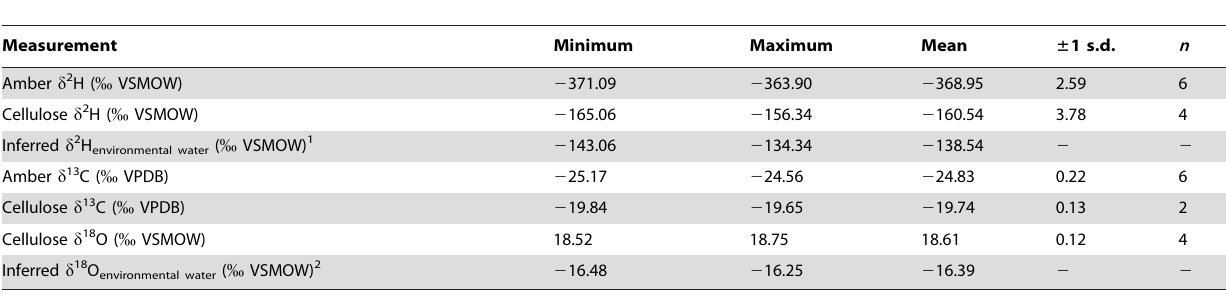
Table 1. Stable isotopic ratios of amber and cellulose extracted from Metasequoia wood entombed in the Panda kimberlite.